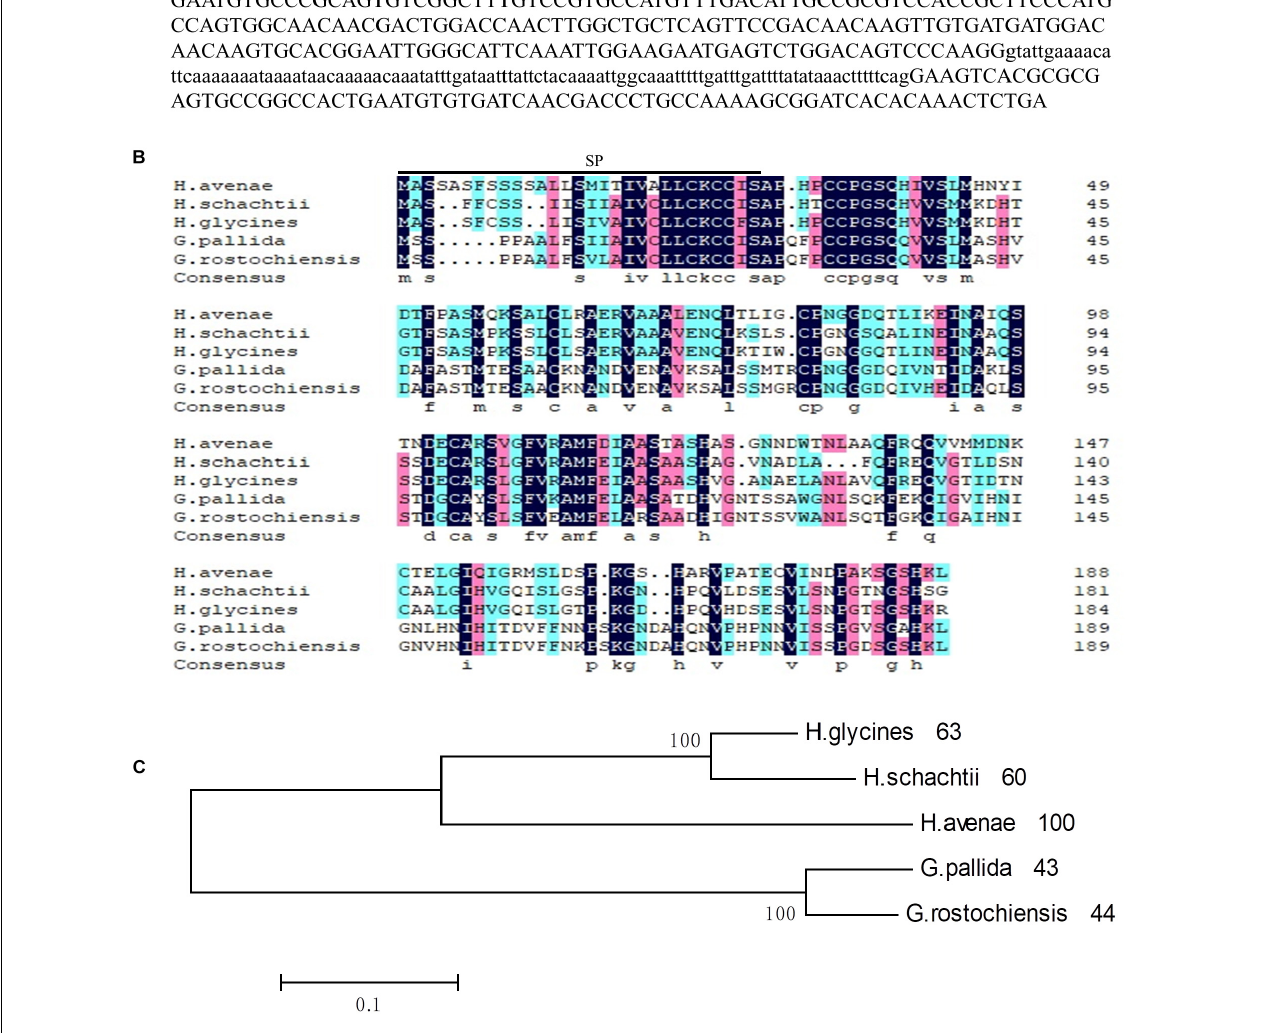
FIGURE 1 | Sequence analysis of Ha18764 from the nematode Heterodera avenae . (A) The DNA sequence of Ha18764 . Three introns are shown in lower-case letters. (B) Multiple sequence alignment of Ha18764 with homologs from other plant-parasitic nematodes. (C) Phylogenetic tree for Ha18764 and its homologs from some other cyst